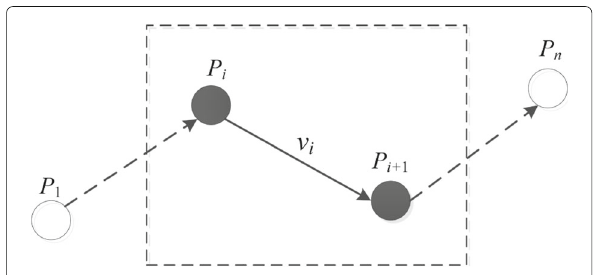
Fig. 3 The speed of grazing trajectory point in continuous time